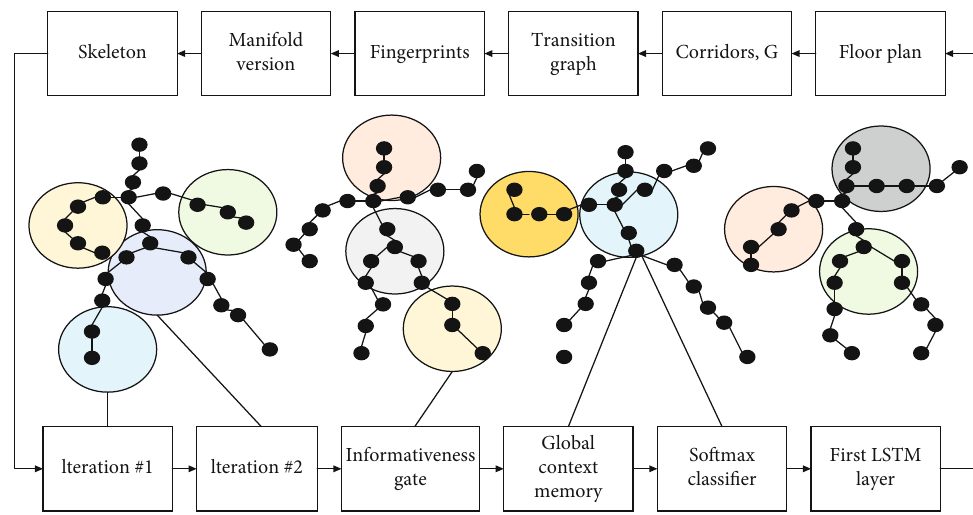
Figure 3: The matching-based 3D skeleton extraction process.